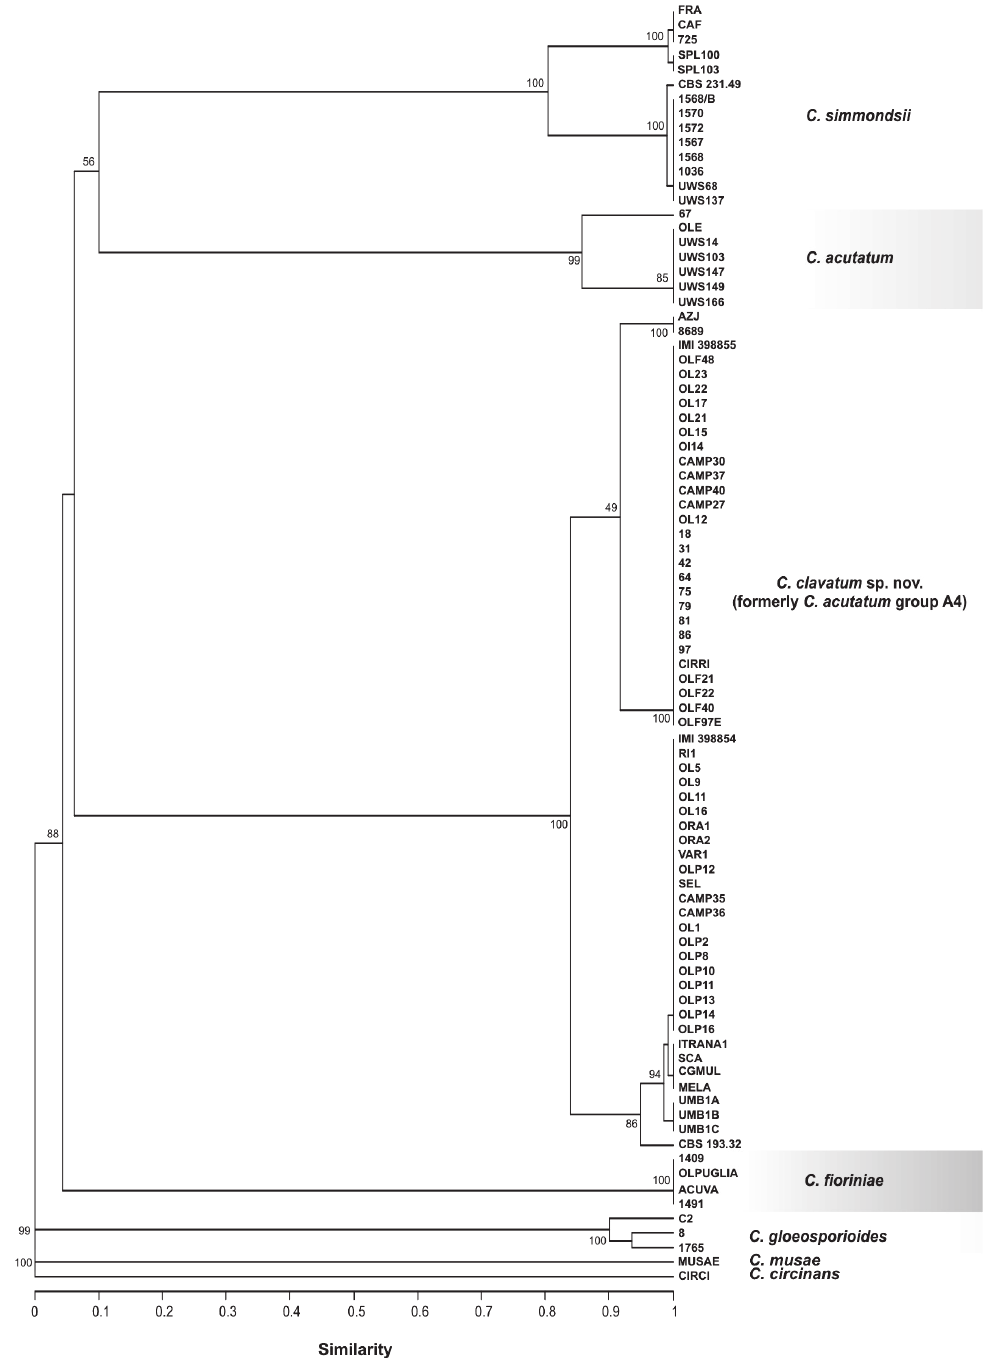
Figure 1. Dendrogram obtained by cluster analysis of RAPD pro fi les of Colletotrichum isolates listed in Table 1. Fig- ures on branches are the bootstrap values as percentage of bootstrap replication from 1,000 replicate analyses. The dendrogram clearly differentiates all isolates of C. clavatum (formerly C. acutatum molecular group A4) from isolates of C. acutatum , C. simmondsii and C. fi oriniae (formerly C. acutatum molecular groups A5, A2 and A3, respectively), as well as from isolates of C. gloeosporioides , C. musae and C. circinans used as